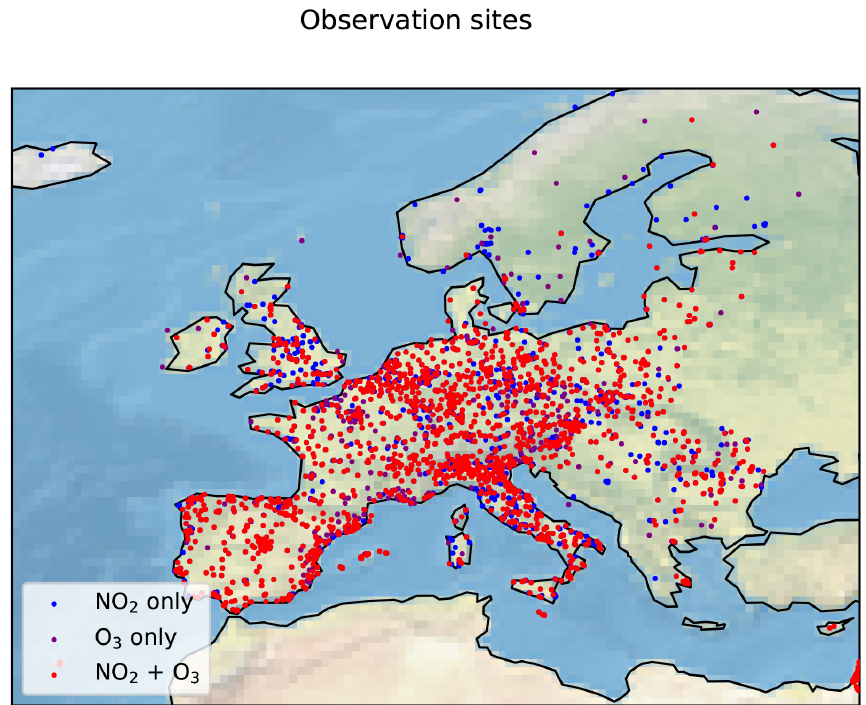
Figure A2. Close-up image of European observation sites included in the analysis. Red points indicate sites with both NO 2 and O 3 observa- tions, purple points show locations with O 3 observations only, and blue points show locations with NO 2 observations only.